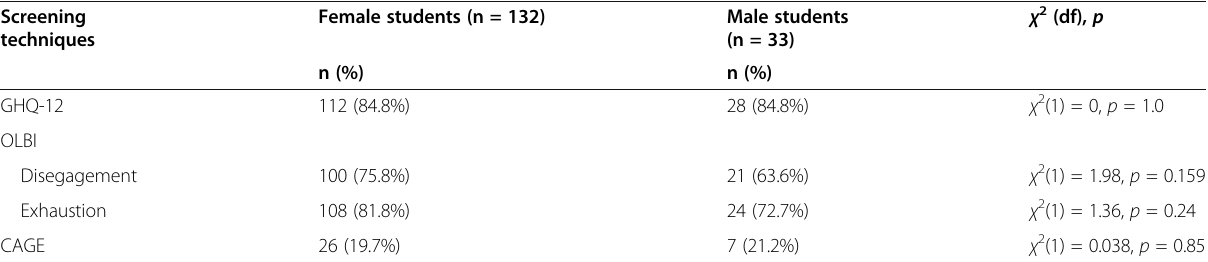
Table 3 Rates of positive GHQ-12, OLBI disengagement, OLBI exhaustion, and CAGE screening by gender of respondents Screening techniques